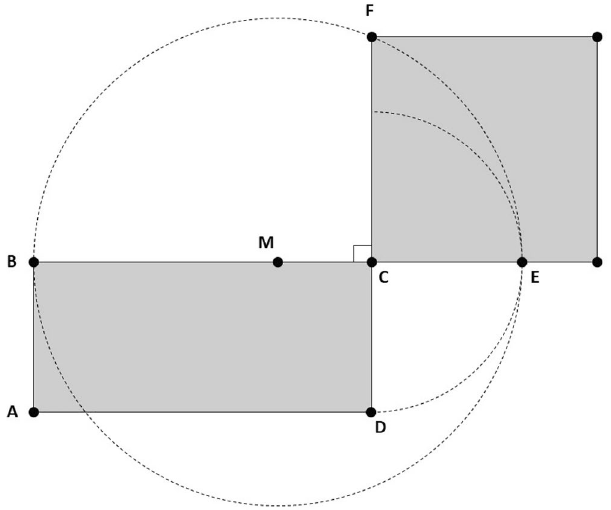
Figure 2. The quadrature of a plane rectangle ⊏⊐ ABCD